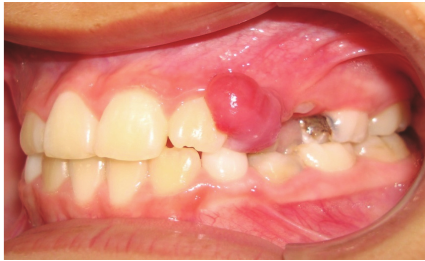
Figure 3: Clinical aspect after excisional biopsy of the